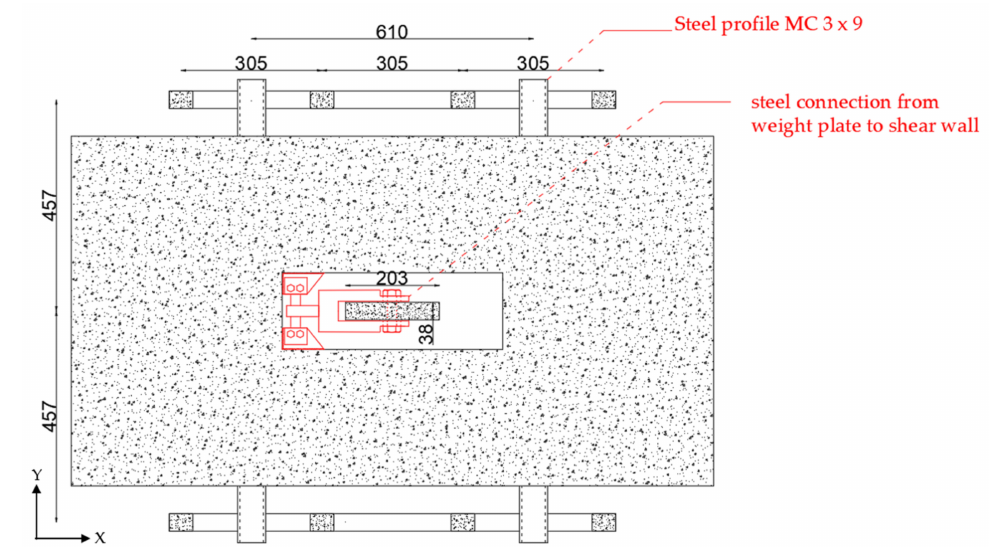
Figure 3. Plan view of the test specimen by Moehle and Sozen; showing connection between RC frames, weighting plates, and RC shear walls (dimension in